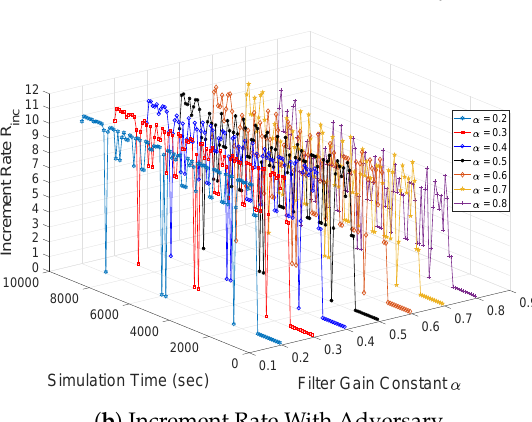
Figure 10. Changes of increment rate of minimum sequence number ( R inc ) against simulation time and filter gain constant α